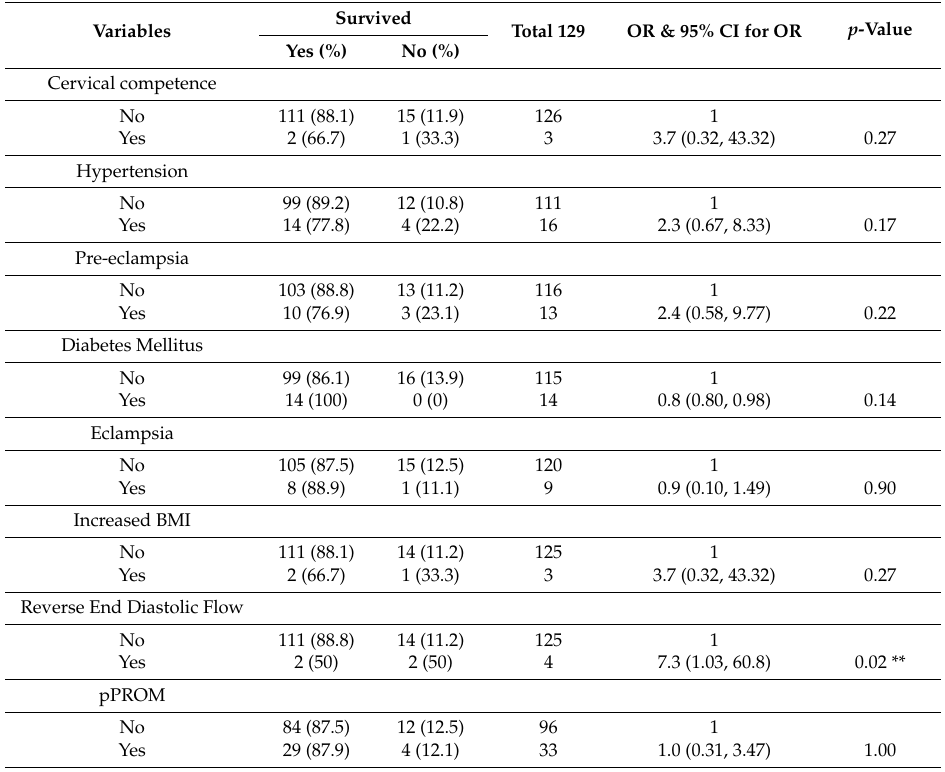
Table 4. Univariate analysis of obstetric complications to assess predictors of preterm neonatal mortality.